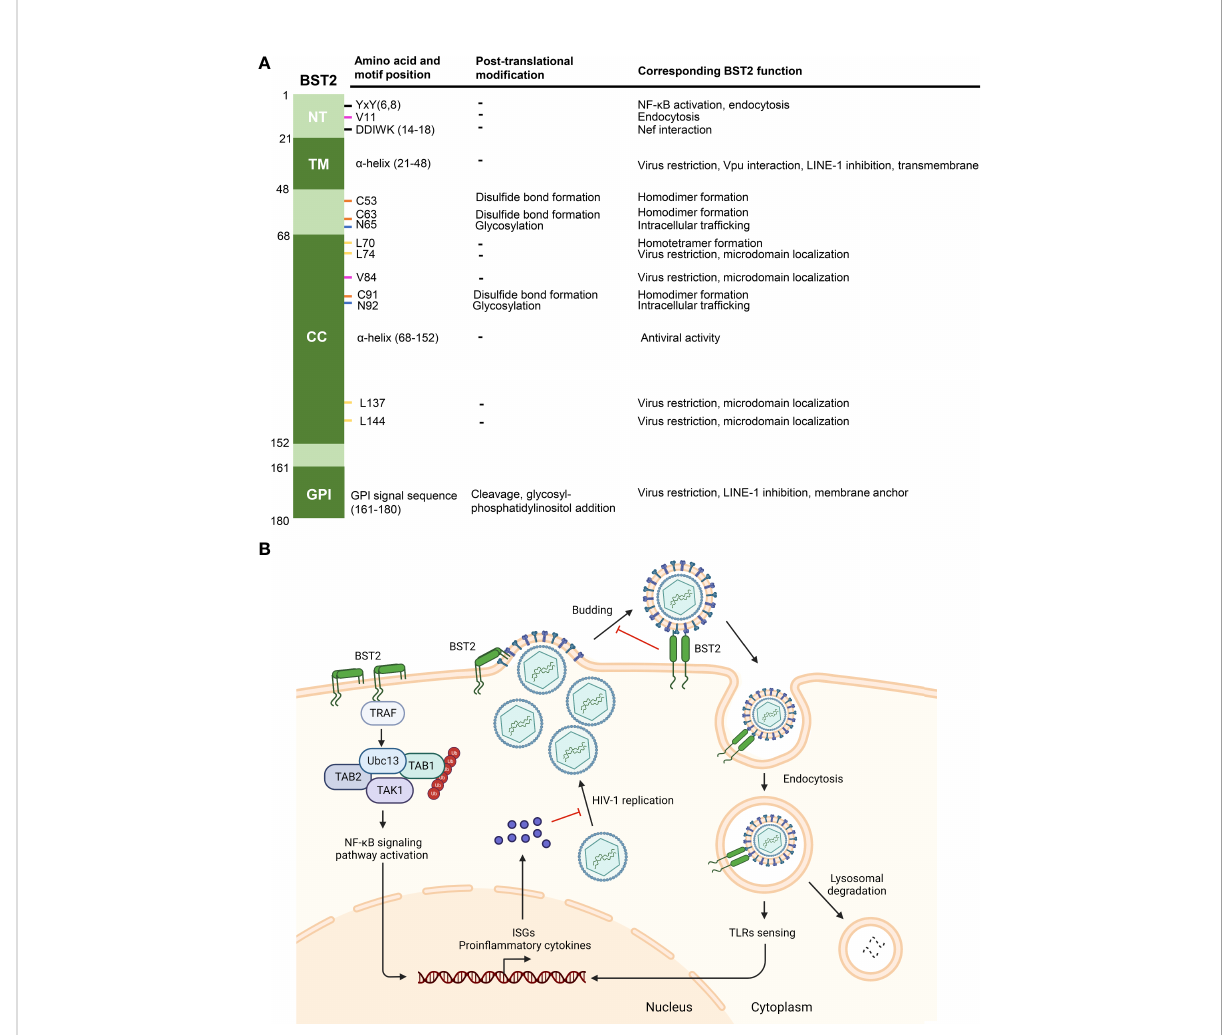
FIGURE 2 Functions of BST2. (A) Post-translational modi fi cations and corresponding functions of BST2 domains and amino acid residues. Speci fi c motifs and residues (amino acid and motif position, fi rst column) implicated in different post-translational modi fi cations (second column) are listed. The roles of motifs and modi fi cations of each residue are listed under ‘ corresponding BST2 function ’ . (B) The diagram showing known anti-HIV-1 functions of BST2. BST2 tethers budding HIV-1 particles to the cell membrane, and the tethered viruses may be internalized and degraded in lysosome. Endocytic vesicles containing BST2 and HIV-1 particles activate ISGs and proin fl ammatory cytokines expression through TLRs sensing, which then inhibits HIV-1 replication. On the other hand, clustering of BST2 dimers induces the activation of NF- k b signaling pathway and subsequent proin fl ammatory responses. Panel B was created with